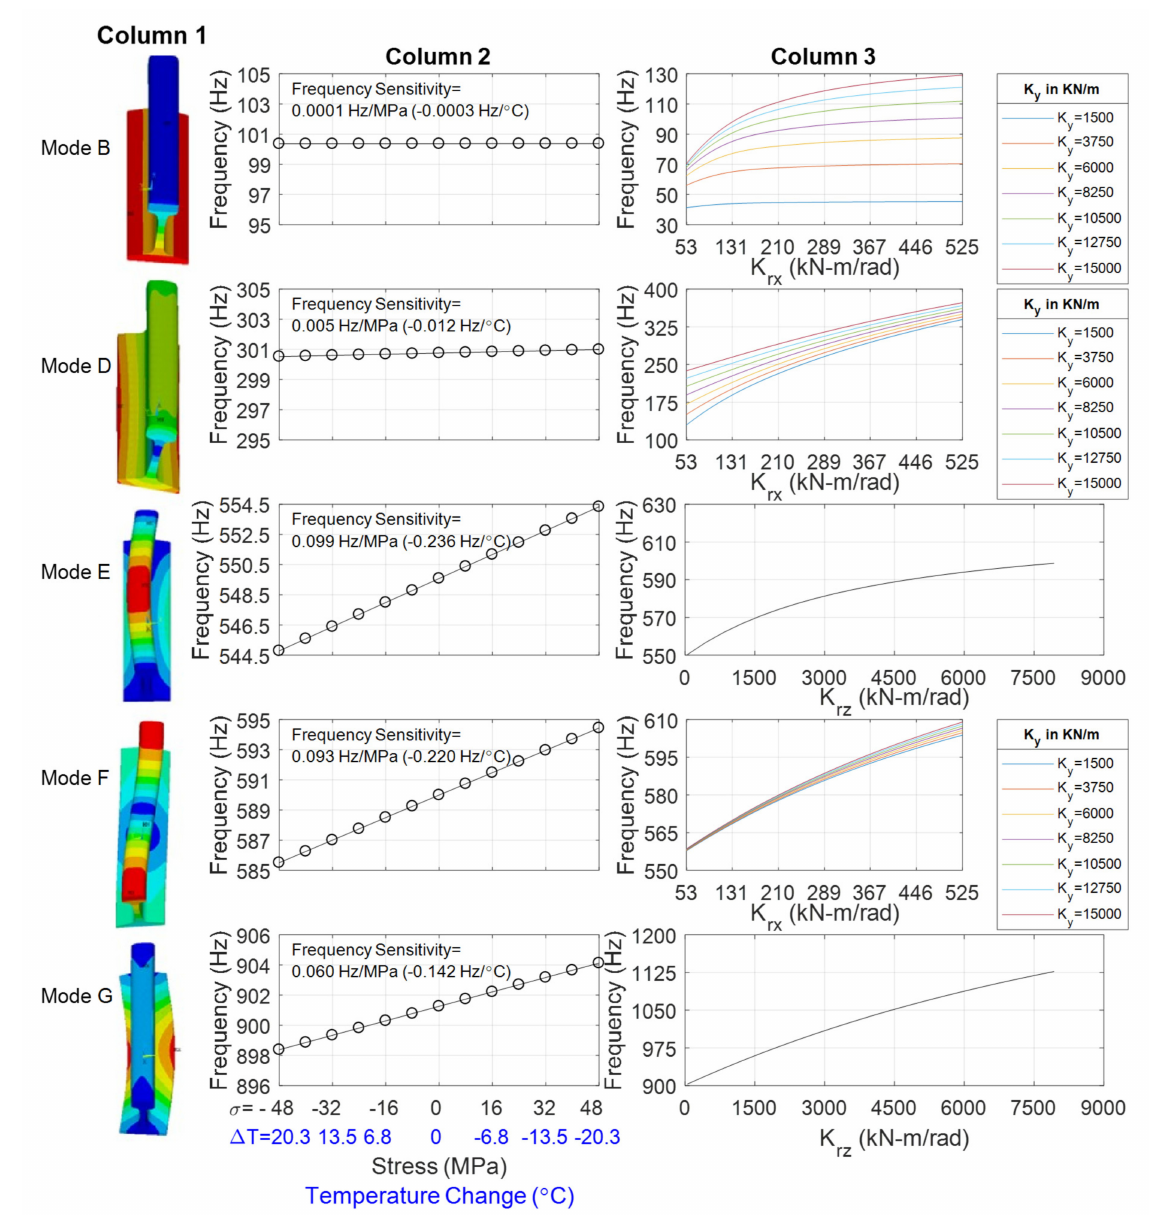
Figure 5. Finite element modeling of a RE 136 tangent track on wood ties. Left column: mode shape of the lowest five modes. Center column: frequency as a function of stress and temperature change (with respect to the RNT) at given boundary condition. Right column: frequency as a function of certain boundary conditions at neutral